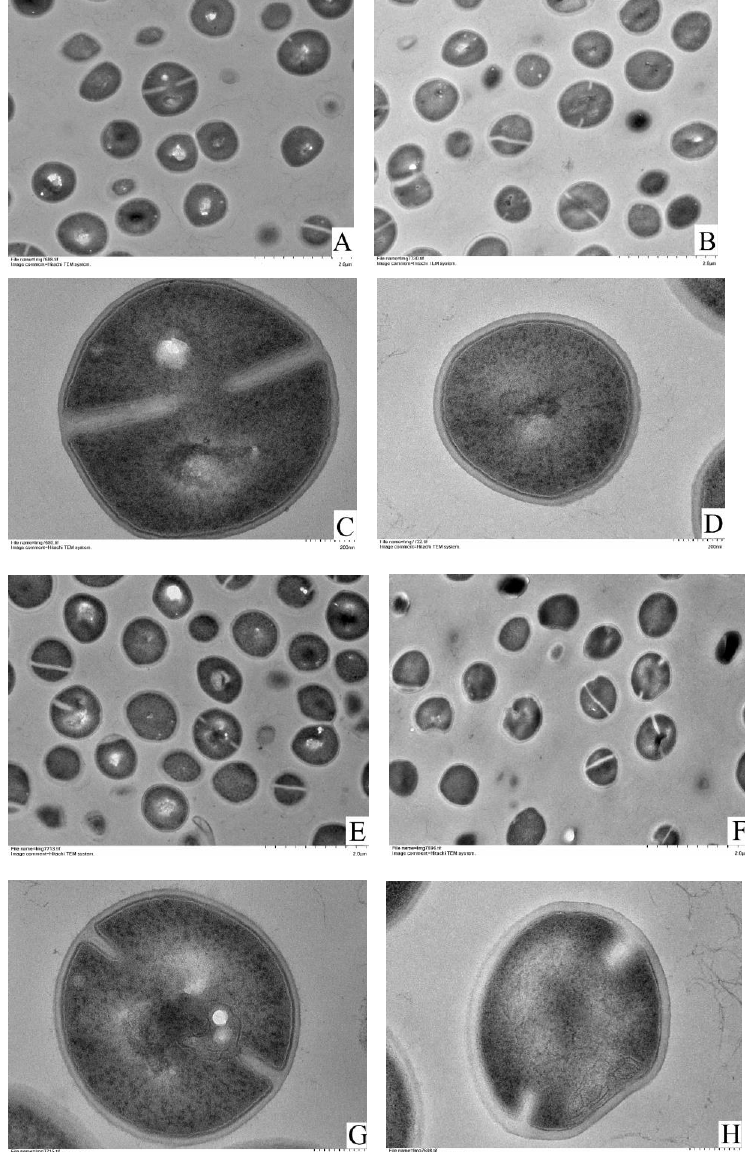
Figure 4. Transmission electron microscopy images of S. aureus in the late exponential stage and exposed to a low temperature (4 °C). White arrows indicate the cells with more severe cell mem- brane wrinkling. ( A , C ): The late exponential stage of BB-11; ( B , D ): the late exponential stage of BA- 26. ( E , G ): BB-11 exposed to a low temperature; ( F , H ): BA-26 exposed to a low temperature. Scale bar = 2 μm in images shown in ( A , B , E , F ) (30,000× magnification); scale bar = 200 nm in images shown in ( C , D , G , H ) (4000×